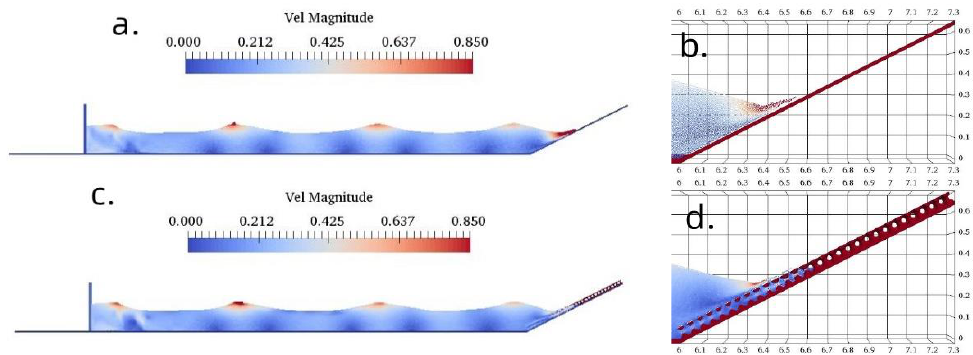
Figure 10. The same as Figure 7, but for wave retreating at t = 6.15 s.